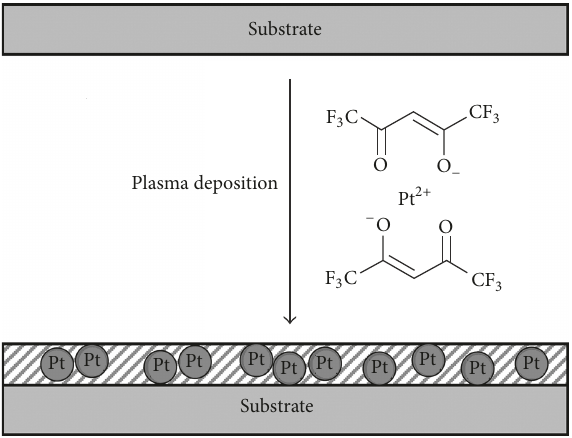
Figure 3: Plasma enhanced chemical vapor deposition [91].